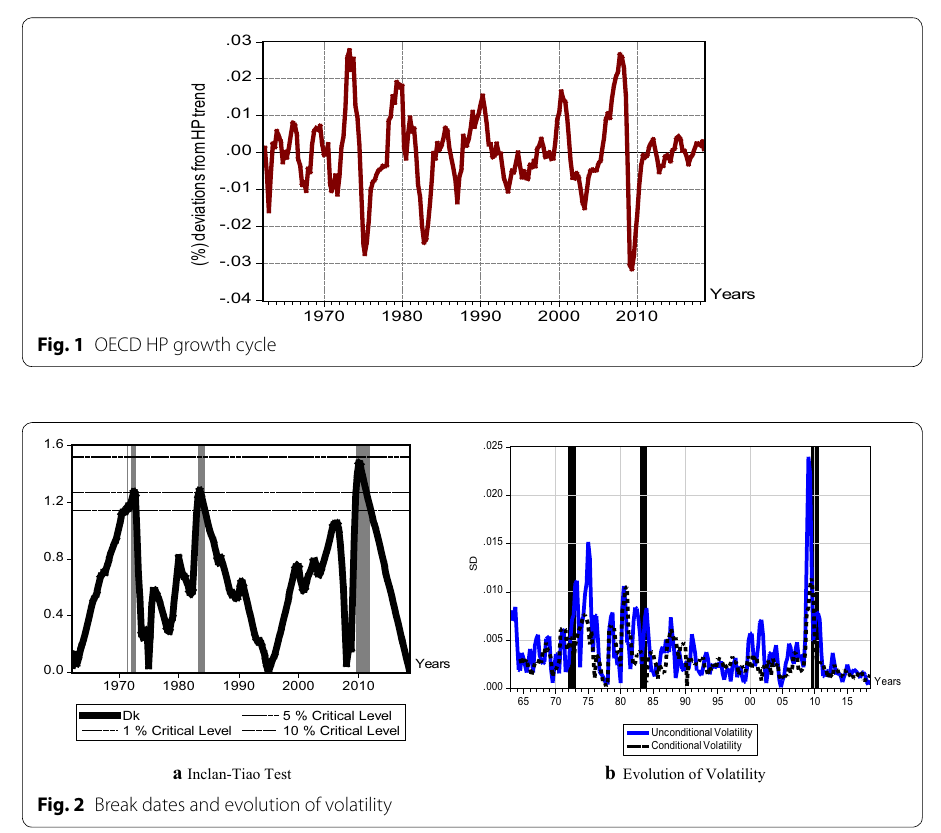
Table 1 Inclan–Tiao test results, break dates and volatilities Break dates